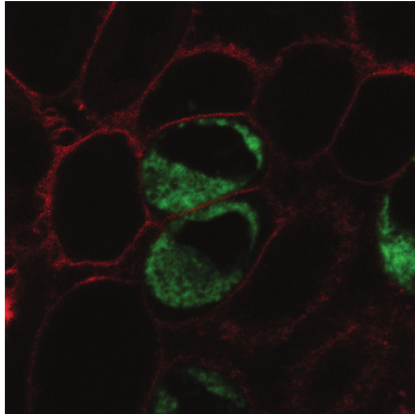
Figure 3: Localization of the GFP-GLP-1 receptor. CHO cells expressing GFP-GLP-1 receptor are viewed under argon-ion laser light source (488nm) and helium-neon laser light source (543 nm) 24-hour posttransfection. Most of the protein is found outside of the nucleolus, in internal membranes (GFP, green dye), but very small amount in plasma membrane (FM4-64, red dye). Imaging is performed 24–48 hours